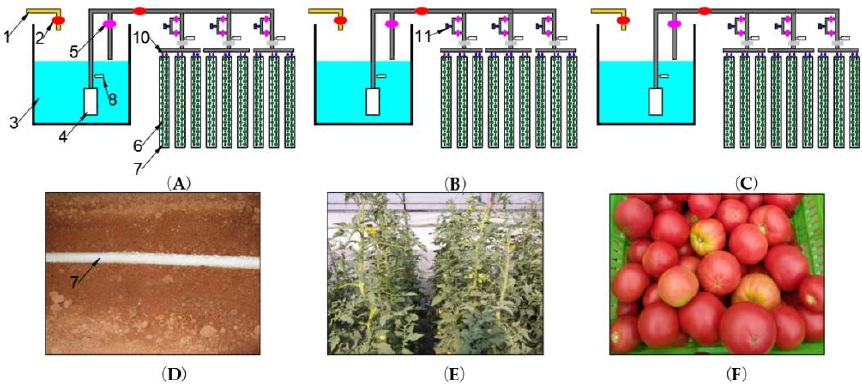
Figure 2. Schematic diagram of moistube irrigation system. Note: 1 represents the headwaters; 2 represents the valve; 3 represents the cistern; 4 represents the water pump; 5 represents the valve; 6 represents the tomato; 7 represents the moistube; 8 represents the filter; 9 represents the capillary valve; 10 represents the pressure gauge; 11 represents the fertilizer applicator. ( A – C ) represent three independent water supply systems, respectively. ( D ) represents the schematic diagram of the moistube irrigation. ( E ) represents the tomato planting. ( F ) represents the tomato harvest.